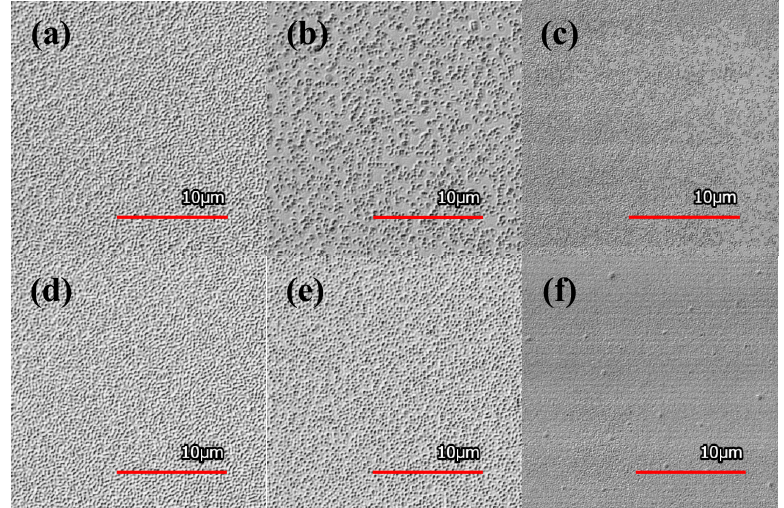
Figure 2. Confocal microscope images of LiNbO 3 surfaces coated with 20 nm thick Yb films after annealing for 30 h. Results for x-cut surfaces annealed at (a) 1000, (b) 1060, and (c) 1130 °C; results for z-cut surfaces annealed at (d) 1000, (e) 1060, and (f) 1130 °C.